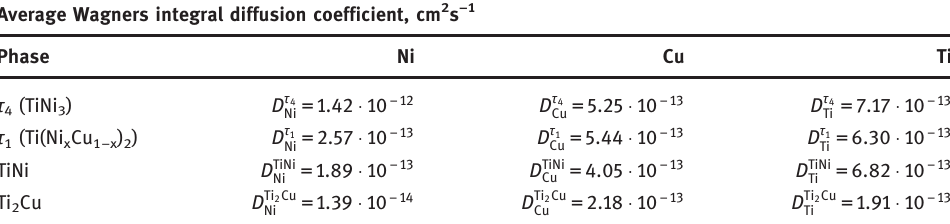
Table 2: The average Wagners integral diffusion coefficient calculated from eq.